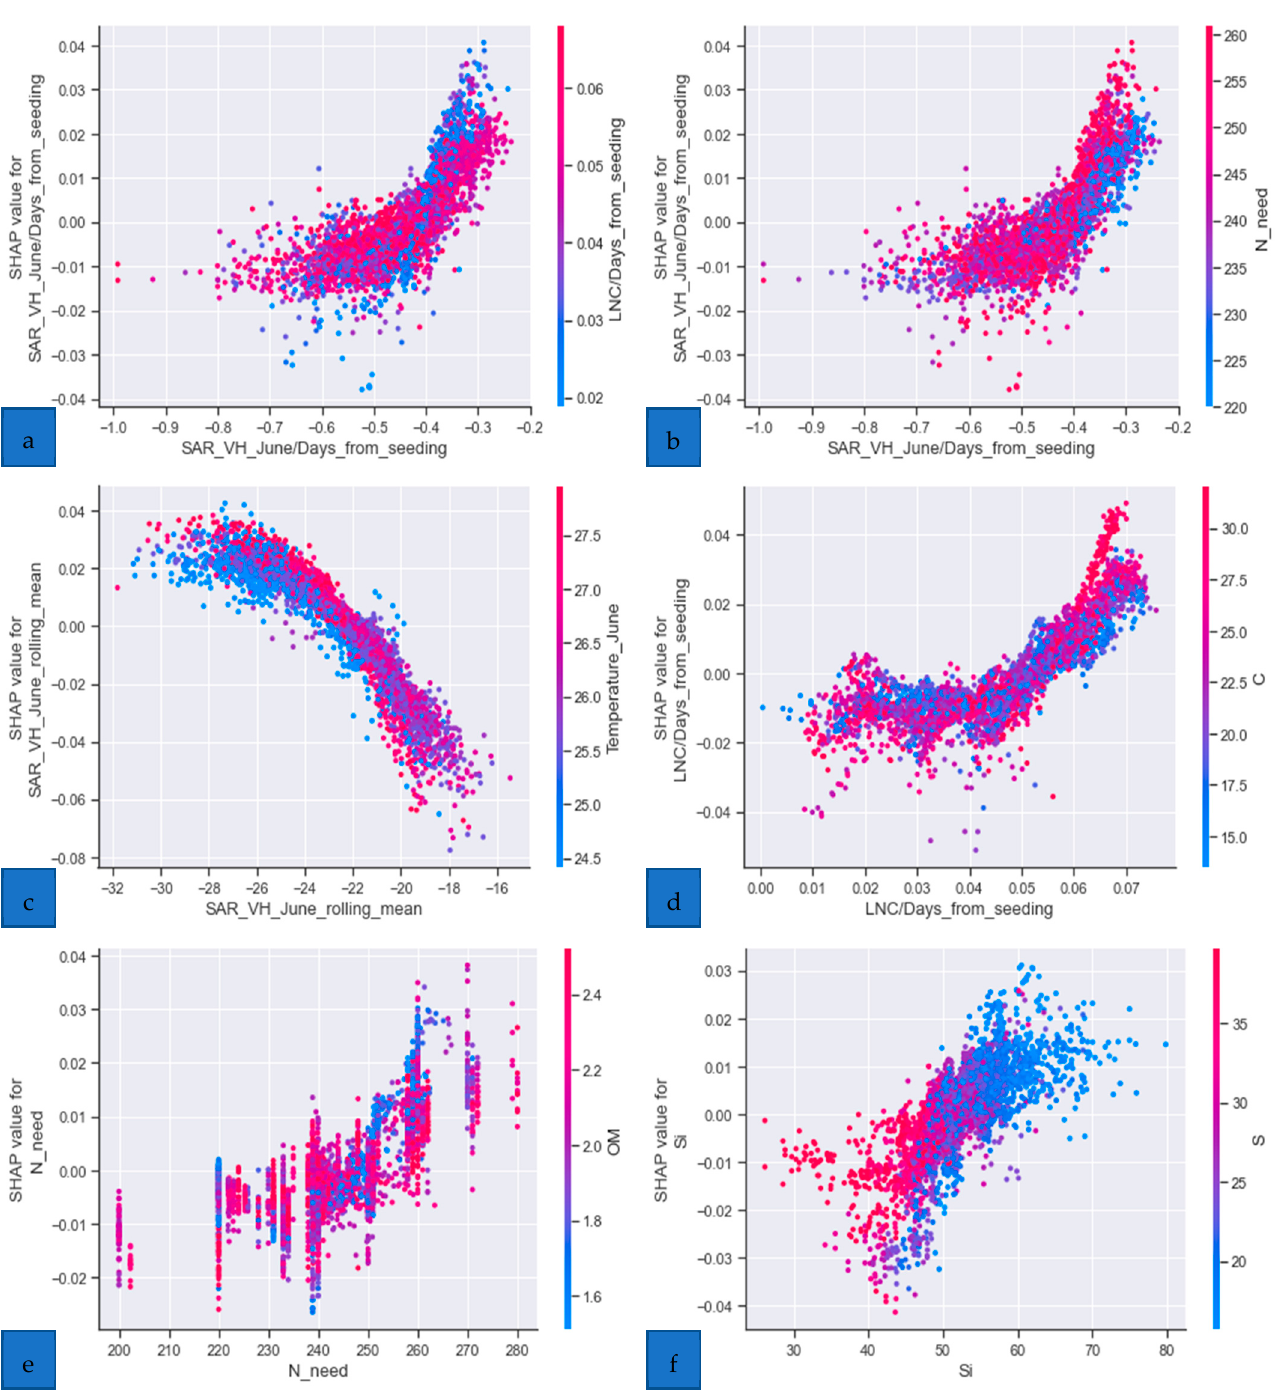
Figure 4. SHAP dependence plots showing ( a – c ) SAR VH of the last SAR image in June divided by the days from seeding, ( d ) LNC divided by the days from seeding, ( e ) N_need and ( f ) Silt influence the prediction of the CatBoost model for yield and their main interactions, i.e., LNC divided by days from seeding, N_need, Temperature of June, precipitation of July, and organic matter and Sand, respectively.